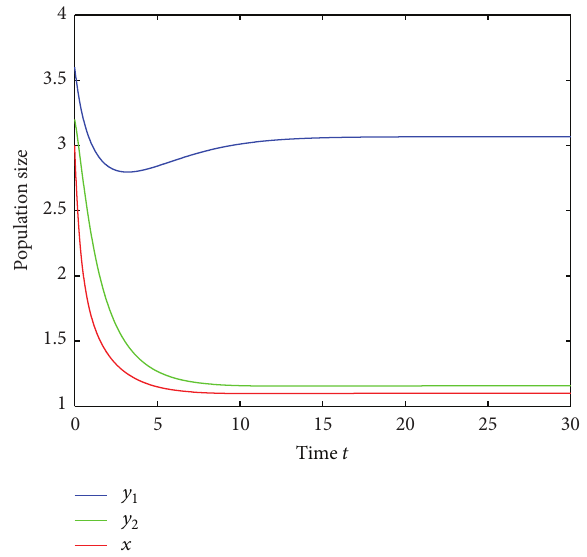
Figure 3: The solution of (2) with initial values 𝑥(0) = 3 , 𝑦 1 (0) = (0) = 3.2 . 3.6 , 𝑦 2